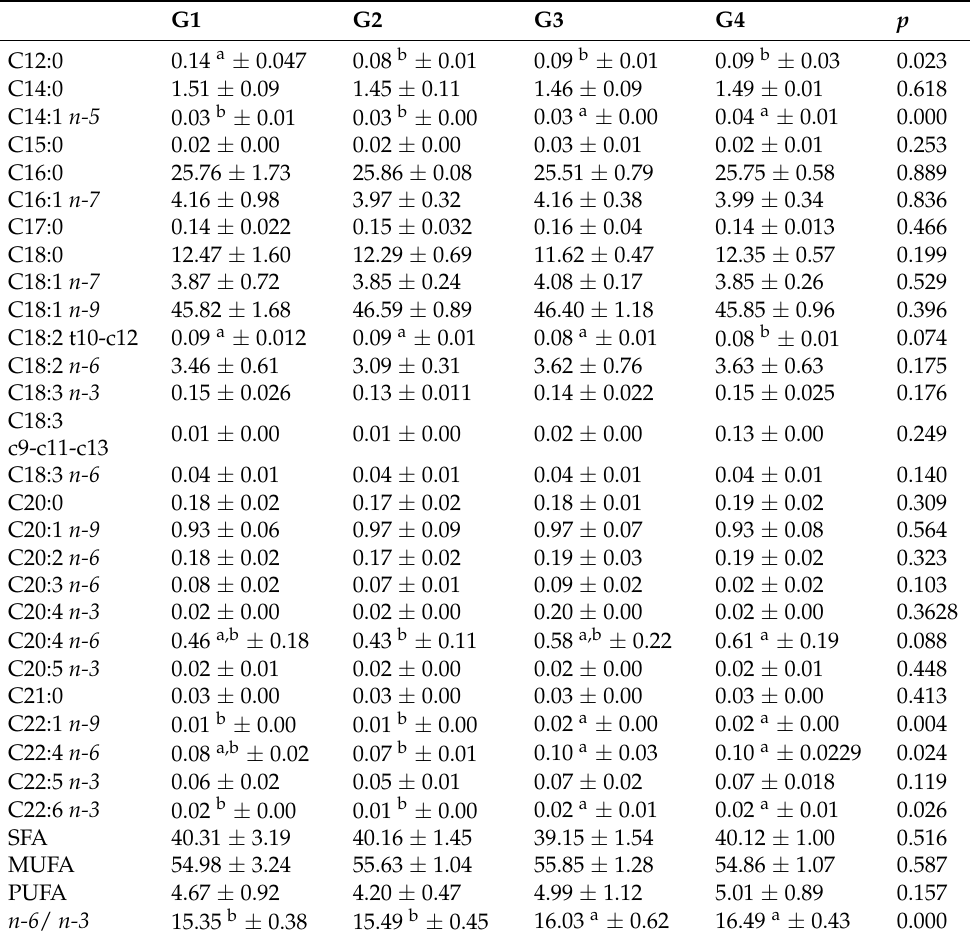
Table 5. Fatty acid profile (mean ± standard deviation) of m. longissimus thoracis from dietary experimental